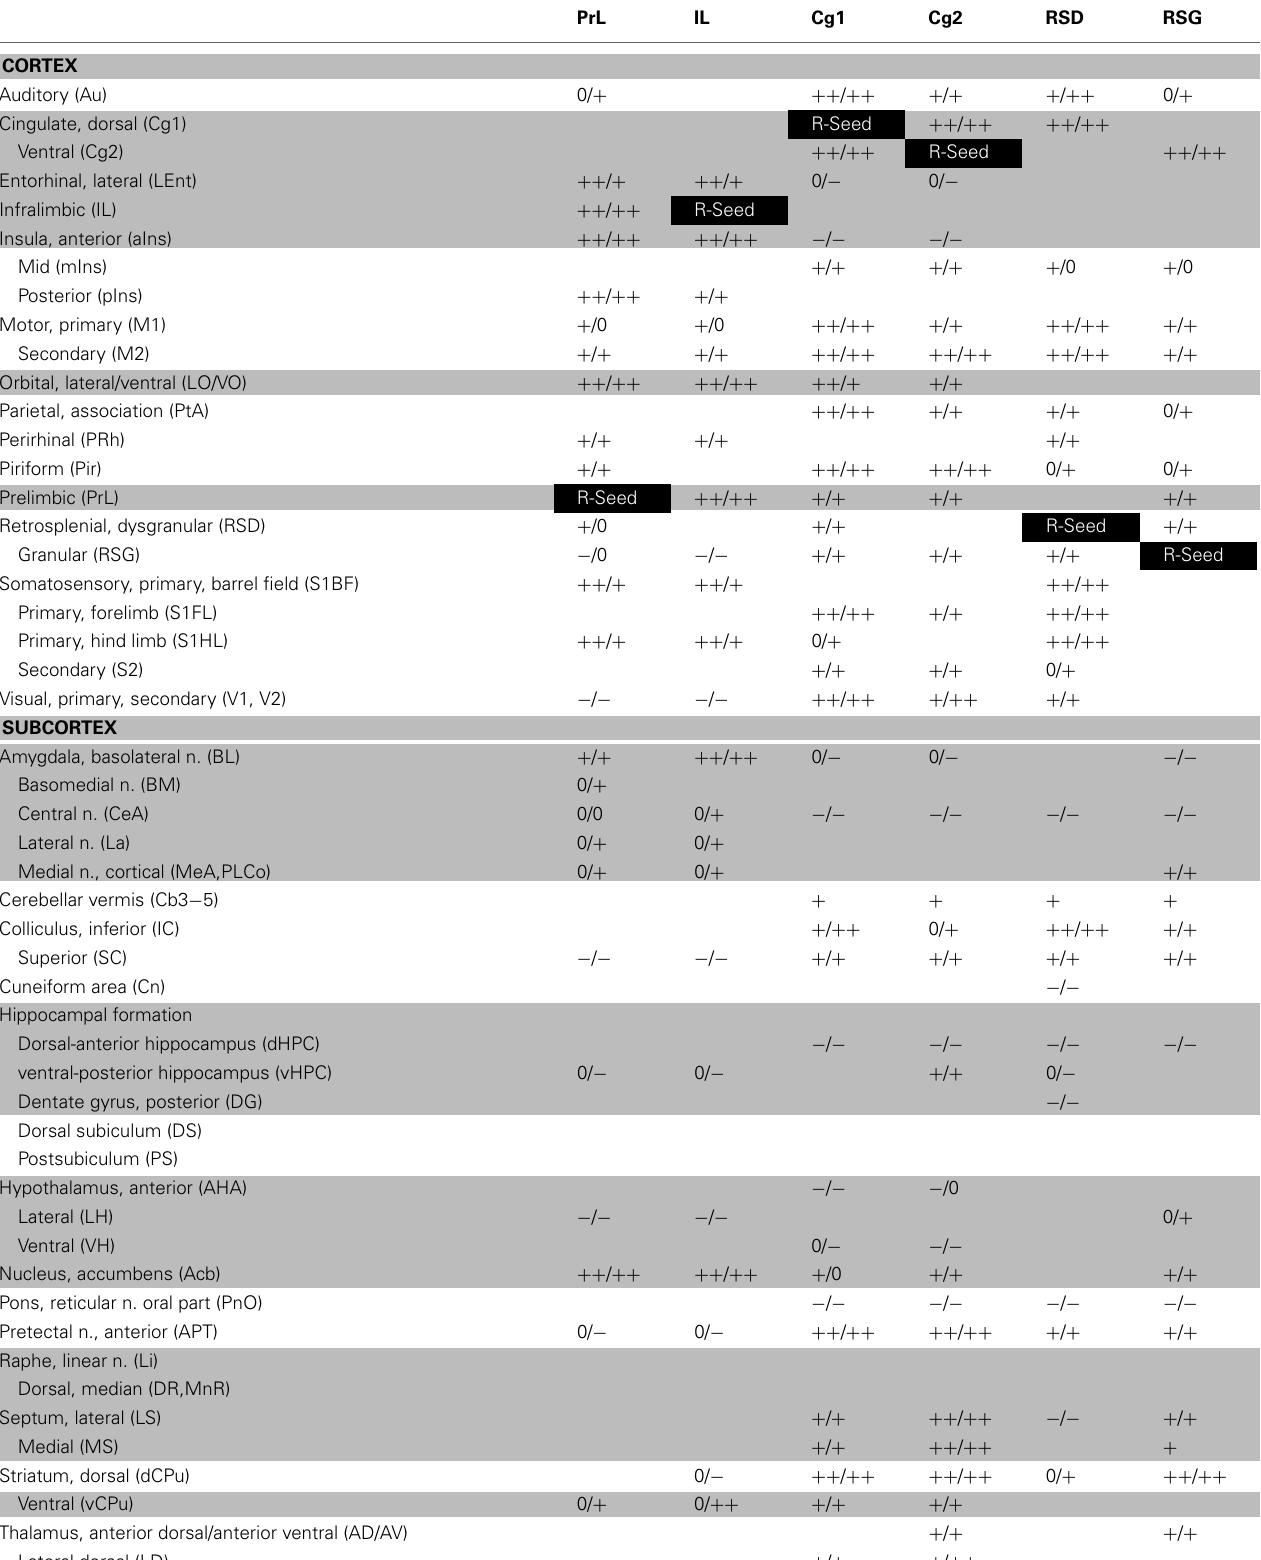
Table 2 | Summary of seed correlation analysis results in the fear-conditioned